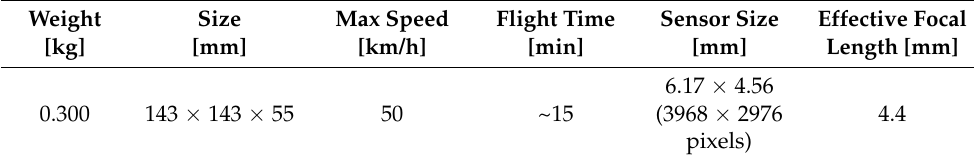
Table 1. Main characteristics of the DJI Spark TM